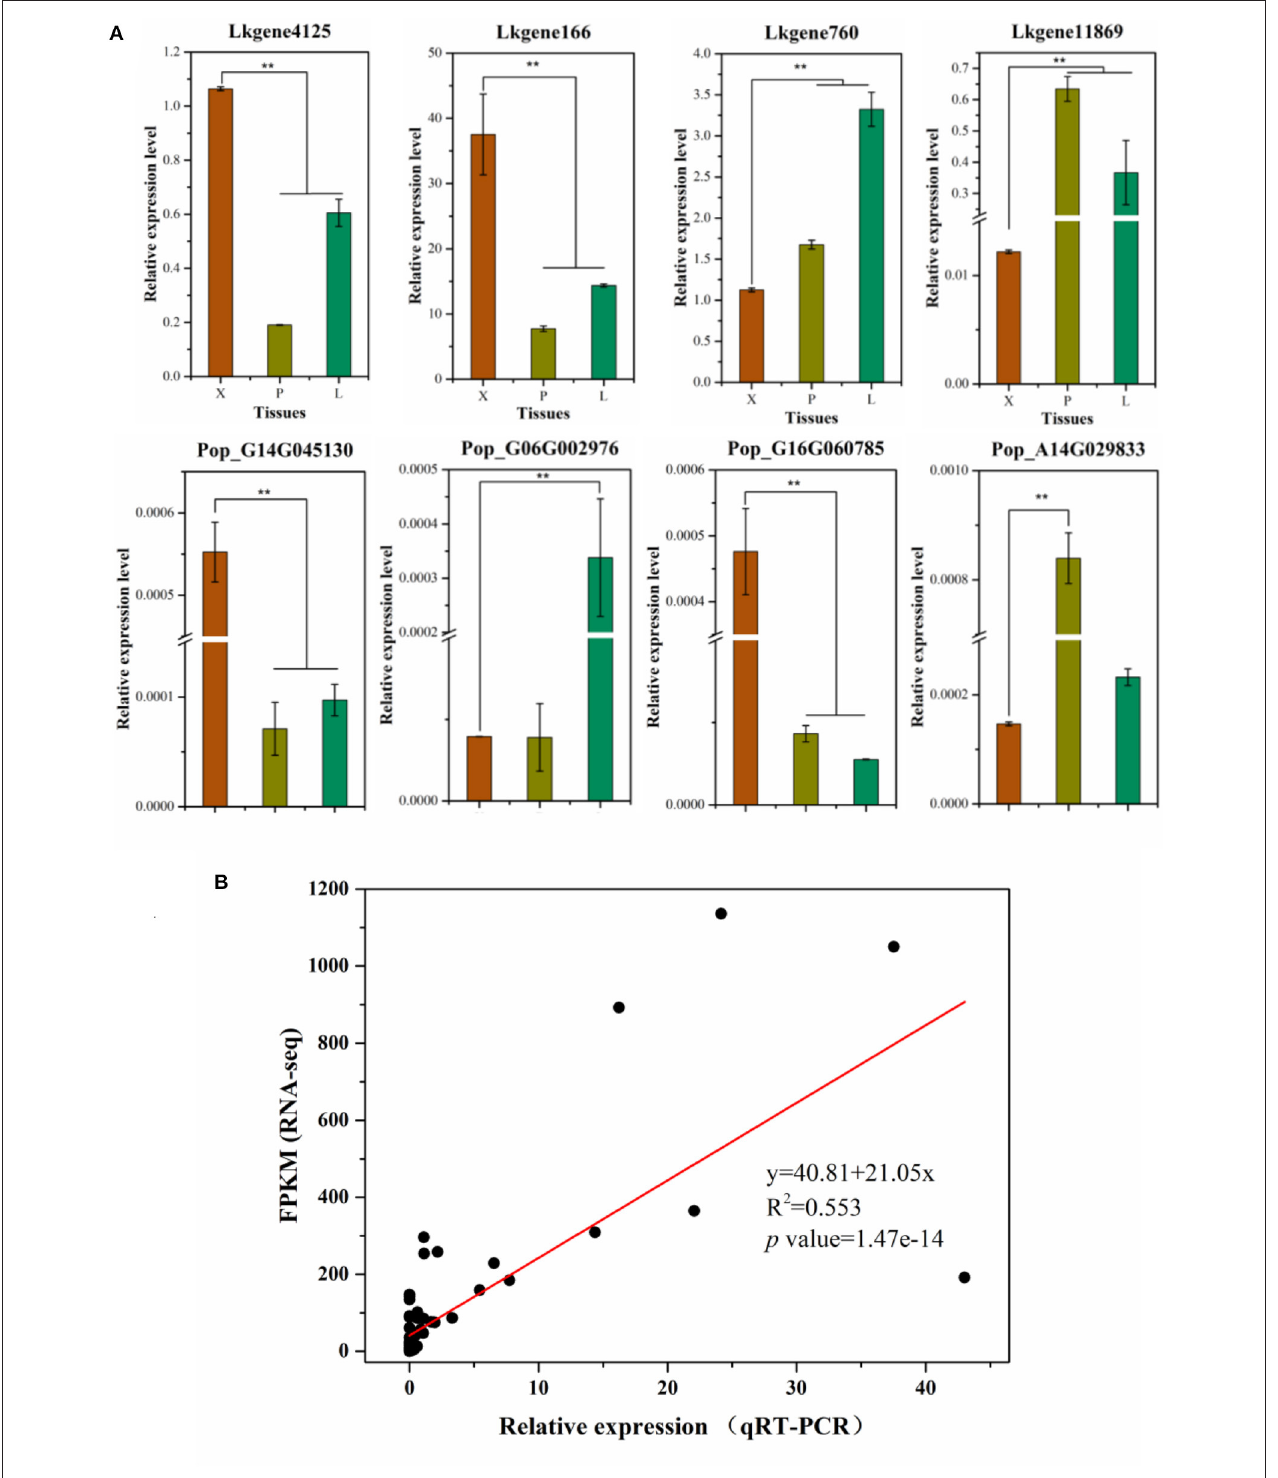
FIGURE 3 | Validation of RNA-Seq results by qRT-PCR. (A) The qRT-PCR results for selected genes in the two tree species. (B) Linear regression for the RNA-Seq and qRT-PCR results. In this graph, gene expression levels in RNA-Seq are standardized by FPKM, the expression levels in qRT-PCR were standardized by the 2 − 1 ct algorithm. In (A) , the relative expression levels in the three tissue types are shown as the mean ± sd; the ** indicates a significant difference at P < 0.01 according to a one-way ANOVA.